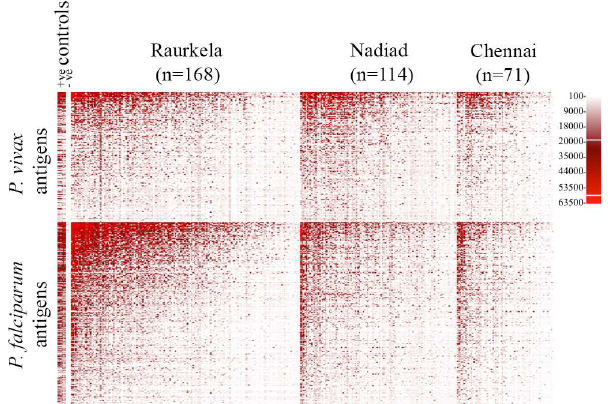
Fig 1. Serological profiles of malaria-positive and malaria-negative individuals from three sites in India. Heat map showing signal intensity of antibodybindingto 265 P . vivax and 373 P . falciparum polypeptides in 236 malaria-positive and 117 malaria-negativesamples collectedfrom Raurkela,Nadiad and Chennai.Red indicatespositive reactivity, white indicatesno reactivity, and the gradientindicates intermediate reactivity. Samples for each site and Plasmodium antigens were rankedfrom left to right and top to bottom, respectively, by decreasing log 2